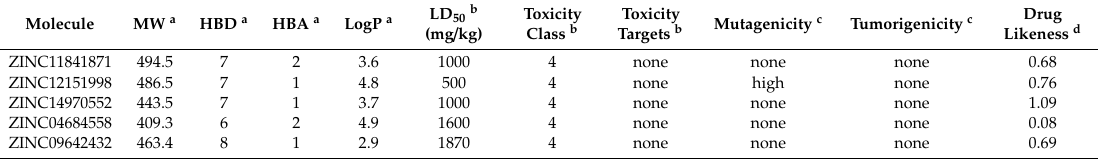
Table 4. Physicochemical and toxicological profiles of LmTR